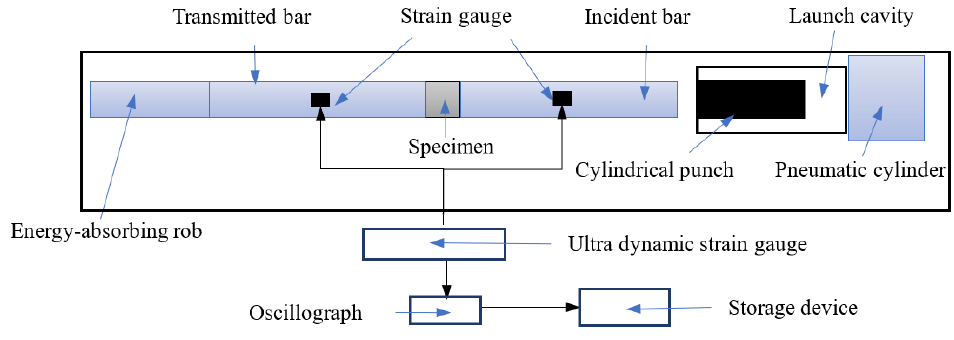
Figure 5. SHPB test system.